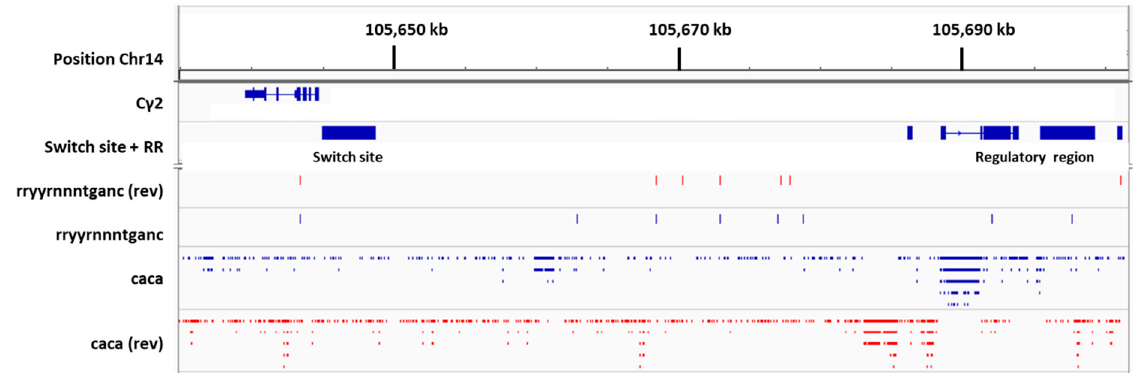
Figure 9. C γ 2 in the human immunoglobulin heavy chain locus. Maps were produced with the hg38 genome using IGV software. The immunoglobulin C γ 2 gene is oriented from right to left. The switch site S γ 2 is shown immediately upstream of C γ 2. Pseudogenes, not shown, exist between the regulatory region and S γ 2. ‘Find motif’ was used to identify potential ERE using the sequence rryyrnnntganc, and to identify CA repeats using the sequence,